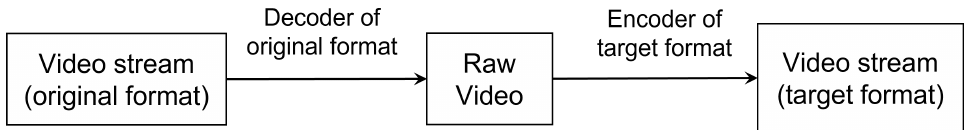
Figure 12. Conventional video transcoding